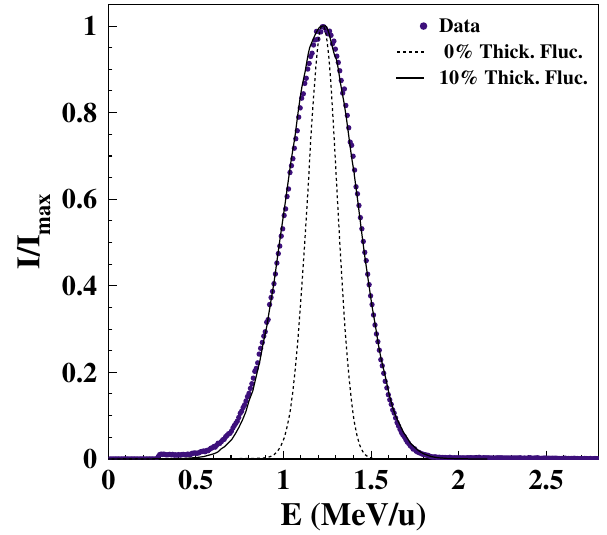
FIG. 4. (Color) Effect of thickness fluctuation. Comparison of the experimental data with SRIM calculation (0% thickness fluctuation) and the parametrization using 10% FWHM thick- ness fluctuation. The data were measured using a 4 MeV proton beam on a 0.005 in. carbon foil [18].